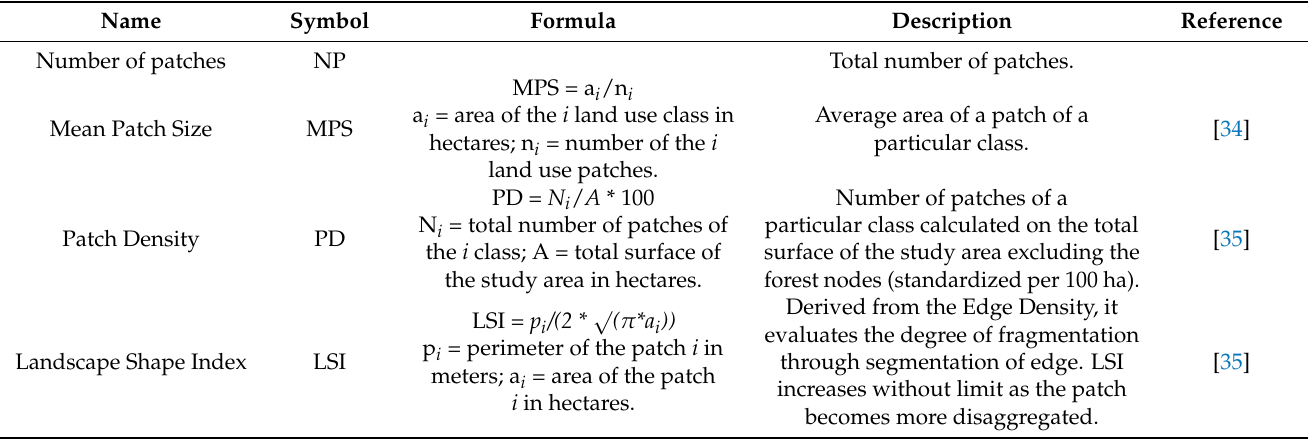
Table 1. Landscape metrics calculated for igune and other small